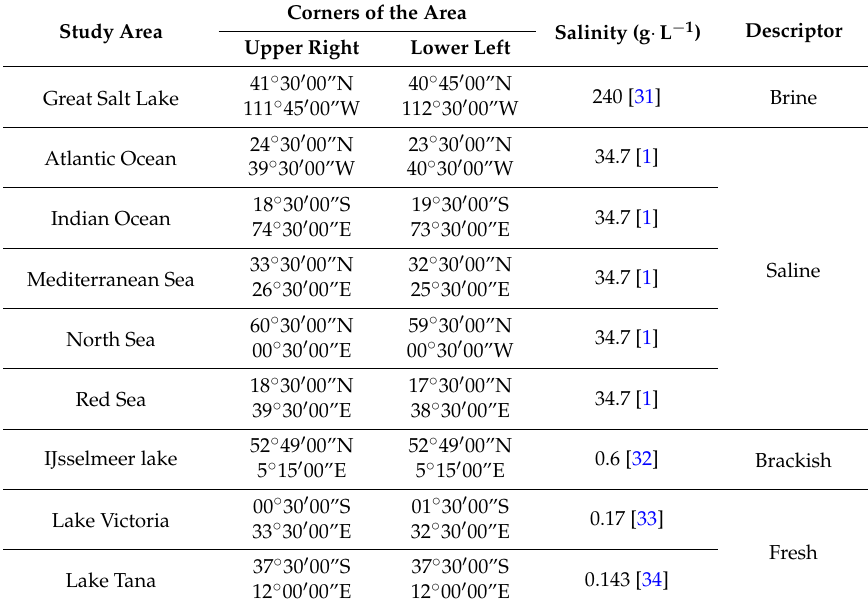
Table 1. Latitude, longitude and salinity of each study